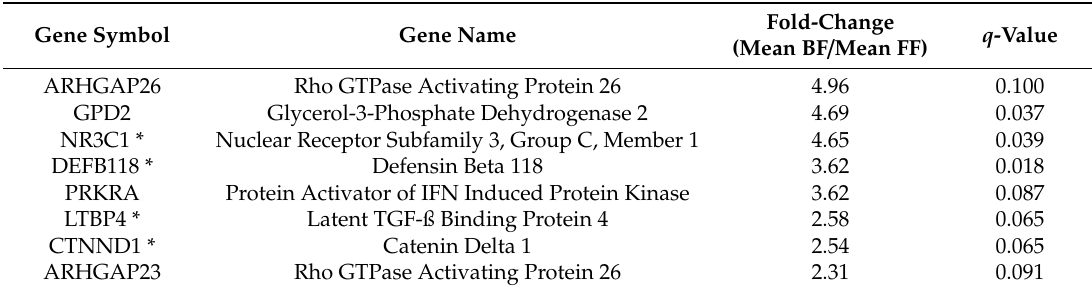
Table 2. Relative expression levels of the top di ff erentially expressed genes in three-month-old breast-fed (BF) vs. formula-fed (FF)